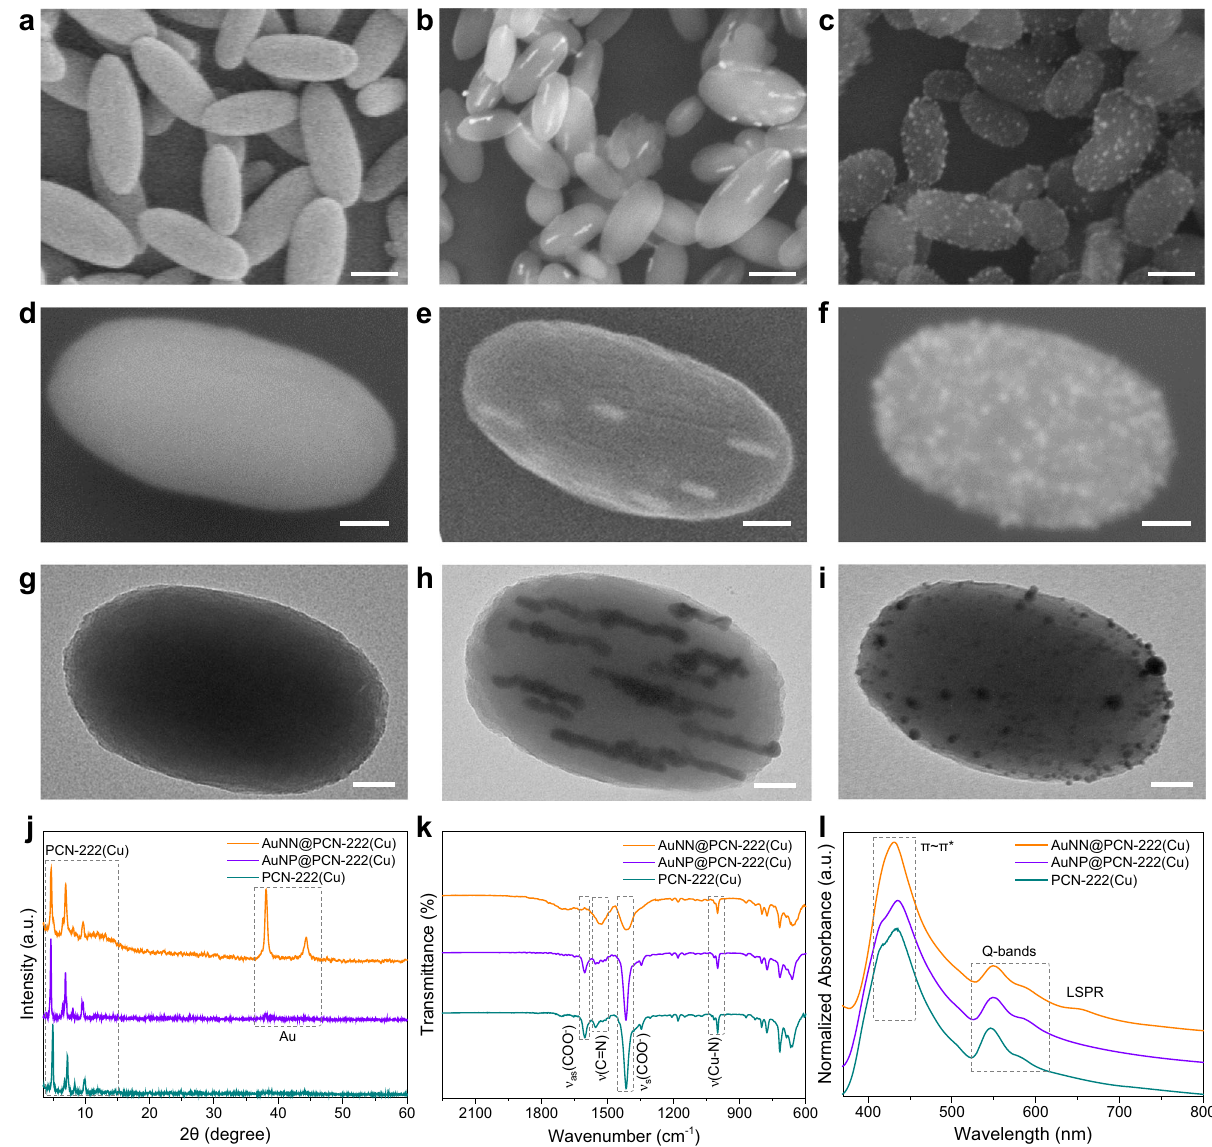
Fig. 2 Structural characterizations of the three PCN-222(Cu) catalysts with and w/o Au. a – c low-magni fi cation, d – f high-magni fi cation SEM, and g – i TEM images of PCN-222(Cu), AuNN@PCN-222(Cu), and AuNP@PCN-222(Cu), respectively. j – l XRD, FT-IR, and UV-vis spectra of the above three catalysts. The scale bars are 250 nm ( a – c ), and 50 nm ( d – i